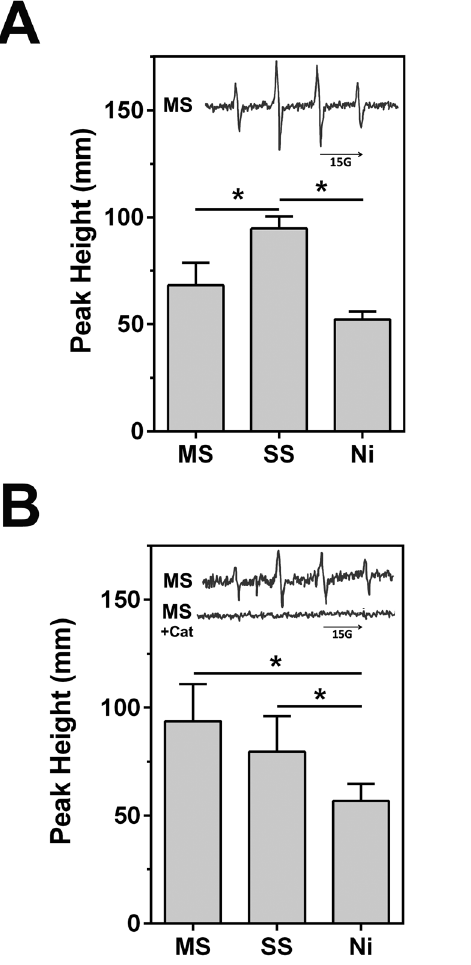
Figure 4. Electron spin resonance measurement of N OH radicals following reaction of welding fumes with H 2 O 2 or RAW 264.7 cells. A. An acellular mixture of welding fume suspensions (1 mg/ml), H 2 O 2 (1 mM), and spin trap DMPO (100 mM) in PBS were incubated in test tubes for 3 min at room temperature, and scanned via ESR. Signal intensity (peak height) is used to measure the relative amount of hydroxyl radicals and error bars represent the mean 6 SD (n=3). Inset: representative GMA-MS spectra. B. The same as in A , except without H 2 O 2 but including 2 6 10 6 RAW 264.7 cells/ml. Samples were incubated at 37 u C for 5 min prior to measurements. (n=5–6). Insets: representa- tive GMA-MS spectra and with catalase treatment ( + Cat) for cellular ESR. *, p , 0.05. Figure 6 shows that only pre-treatment with Ni-Cu WF significantly impaired subsequent phagocytosis of a pathogen- based particle compared to PBS controls (72.3 6 2.1% and 74.5 6 10.8% at 3 and 6 hours, respectively, mean 6 SD) while GMA-MS and GMA-SS had no effect at these time points and at this concentration. These results suggest that perhaps pre-uptake of GMA-MS and GMA-SS cause cells to produce more ROS, whereas Ni-Cu WF negatively affects macrophage function by reducing the phagocytic ability prior to cytotoxicity. We hypoth- esize that whatever negative effect these particles had on the RAW 264.7 cells’ ability to phagocytose bacteria was already occurring by the 3 hour time point. Thus, at 6 hours and perhaps later times, the cells would still not be able to properly take up the E. coli